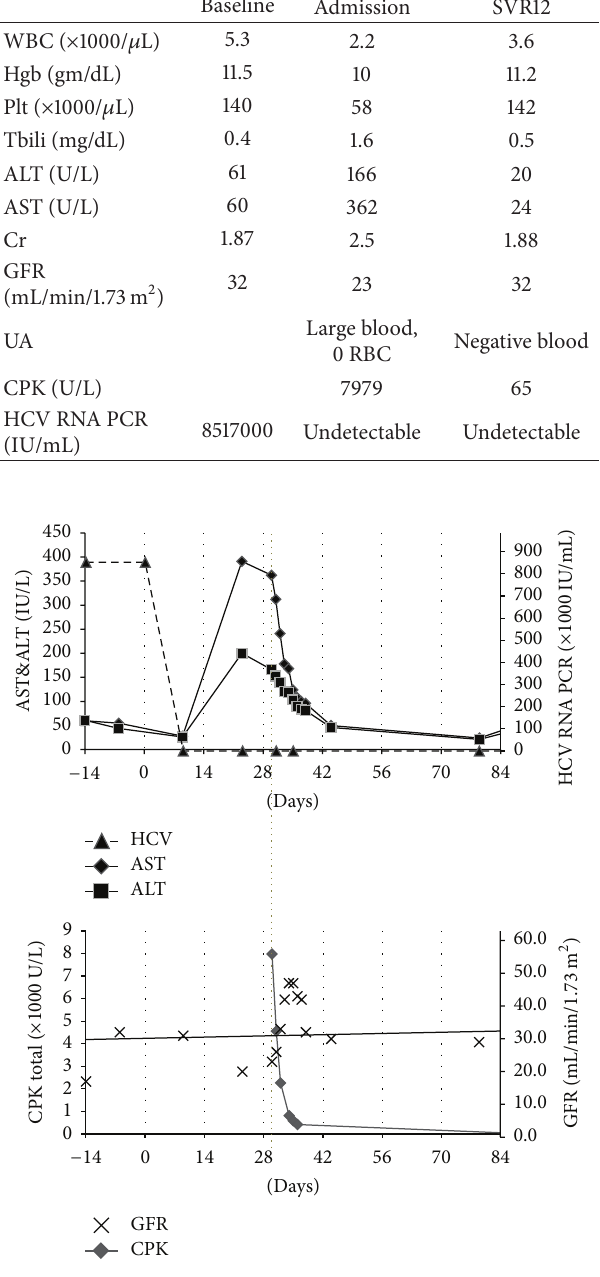
Figure 1: Timeline of laboratory changes. Interrupted line denotes hospital admission